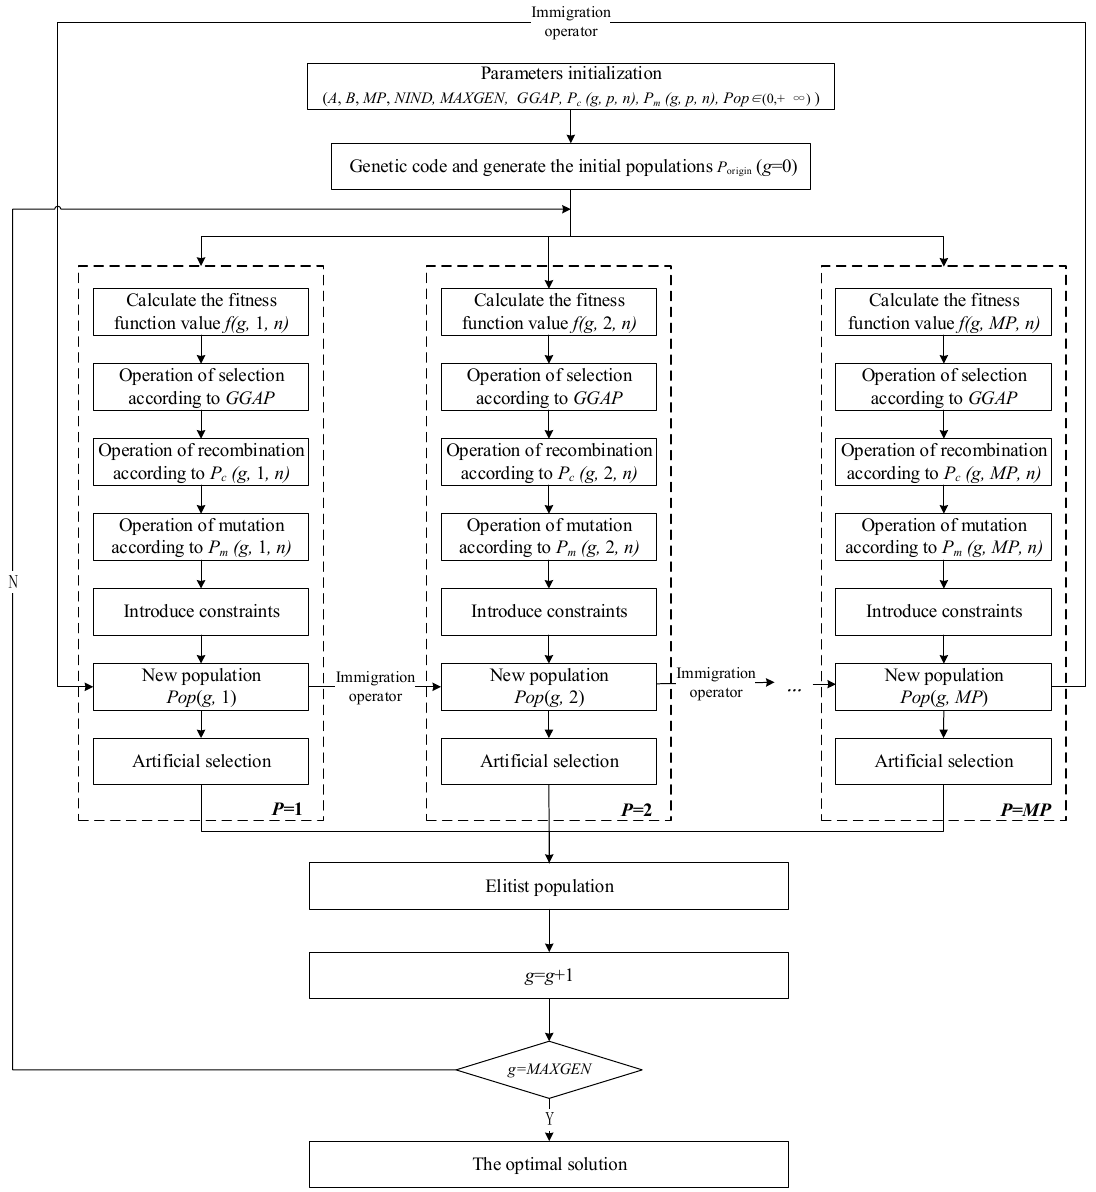
Figure 2. Flow chart of adaptive multi-population parallel genetic algorithm (AMPGA) with constraints.